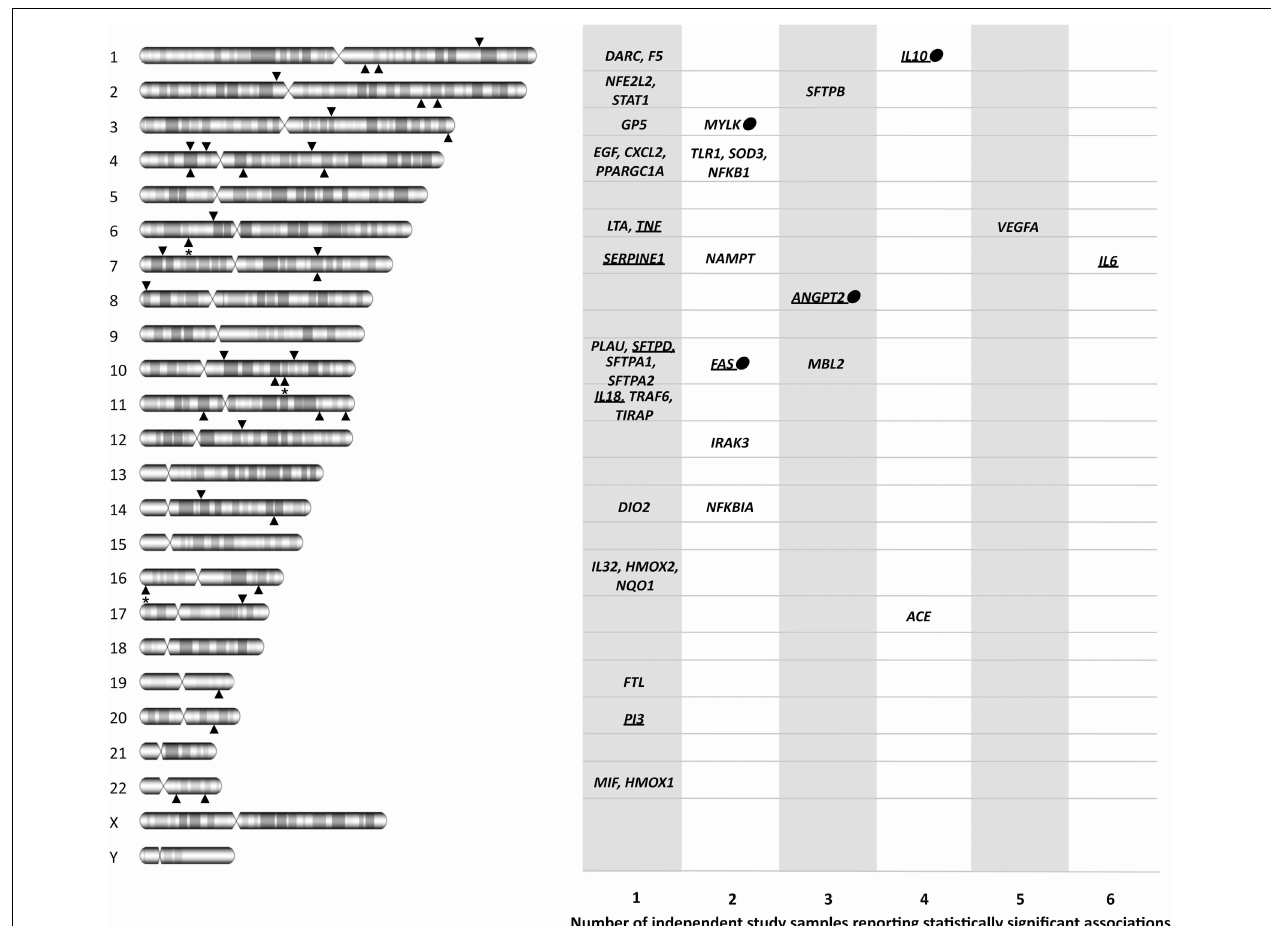
FIGURE 2 | Diagram showing the official gene symbols for the 41 candidate genes associated with ARDS susceptibility and outcomes, depicting both chromosome locations and the number of study samples with statistically significant associations. For each chromosome, lower arrowheads indicate the location of genes with a single sample association, and upper arrowheads indicate the location of genes with statistically significant association findings in at least two study samples. Arrowheads with asterisk indicate more than one gene in that region. Dots denote that the gene was replicated in the only GWAS of ARDS published to date. Underlined gene names indicate that the product has been suggested as a biomarker for ARDS or its progression in at least one study. ACE , angiotensin I converting enzyme; ANGPT2 , angiopoietin 2; CXCL2 , chemokine (C-X-C motif) ligand 2; DARC , duffy blood group, chemokine receptor; DIO2 , deiodinase, iodothyronine, type II; EGF , epidermal growth factor; F5